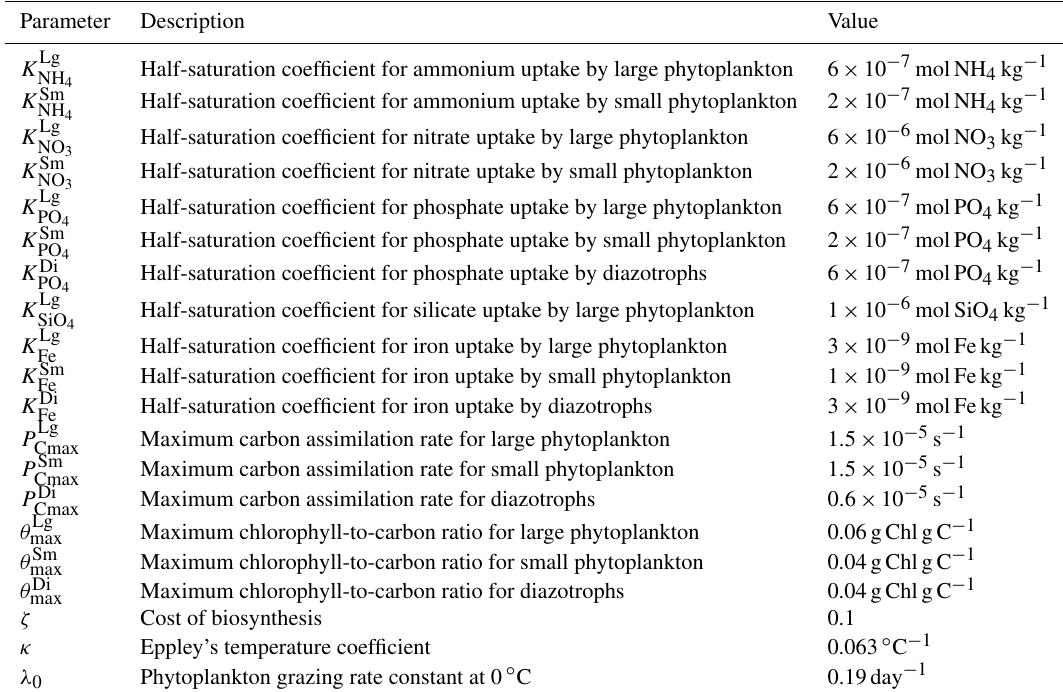
Table 1. Details of biological parameters used in the ecosystem model.